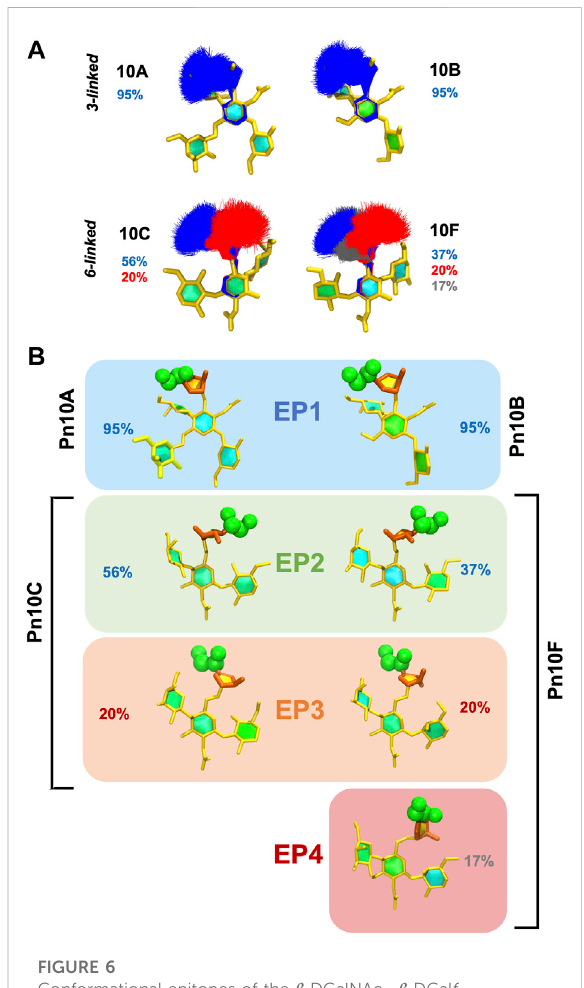
FIGURE 6 Conformational epitopes of the β DGalNAc — β DGal f disaccharide in S. pneumoniae serogroup 10, RU 4. (A) Super- imposed conformational families ( > 5%) ofthe β DGalNAc — β DGal f disaccharide with associated percentages for the four CPS molecules. (B) Representative conformational epitopes (EP1-4) of the β DGalNAc — β DGal f disaccharide for the four CPS molecules, with associated percentage occupancies, grouped according to conformational